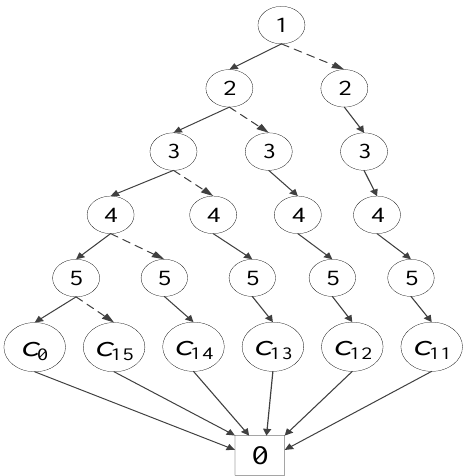
Figure 4. BDD of the example 4-out-of-5 cloud-RAID 5 with FLC